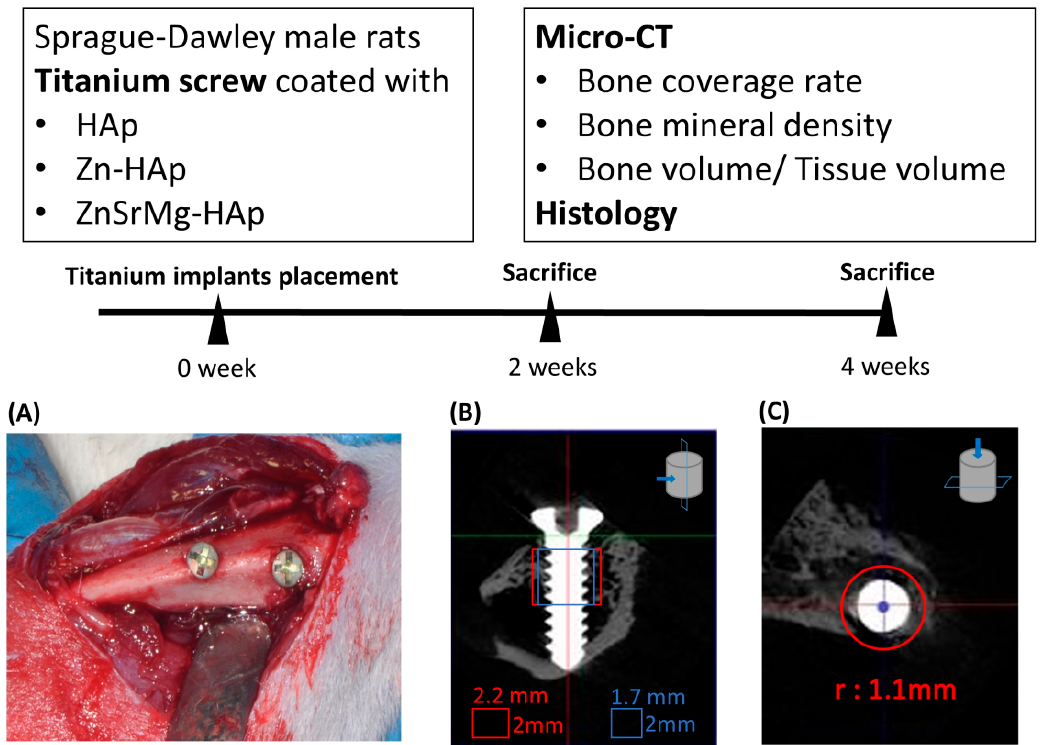
Figure 7. Flowchart of animal study and measurement of new bone formation. ( A ) Two titanium implants with different HAp coatings were placed in rat tibias. ( B ) For bone coverage rate, the ROI was set as a cylinder (0.85 and 1.1 mm in diameter and 2.0 mm in height) starting from the implant center. The radius of the titanium implant was 0.6 mm. ( C ) For BV/TV and bone mineral density, the ROI was defined as a cylinder (1.1 in diameter and 2.0 mm in height) starting from the first thread of the titanium implant. ROI: region of interest; BV/TV: bone volume/total volume.